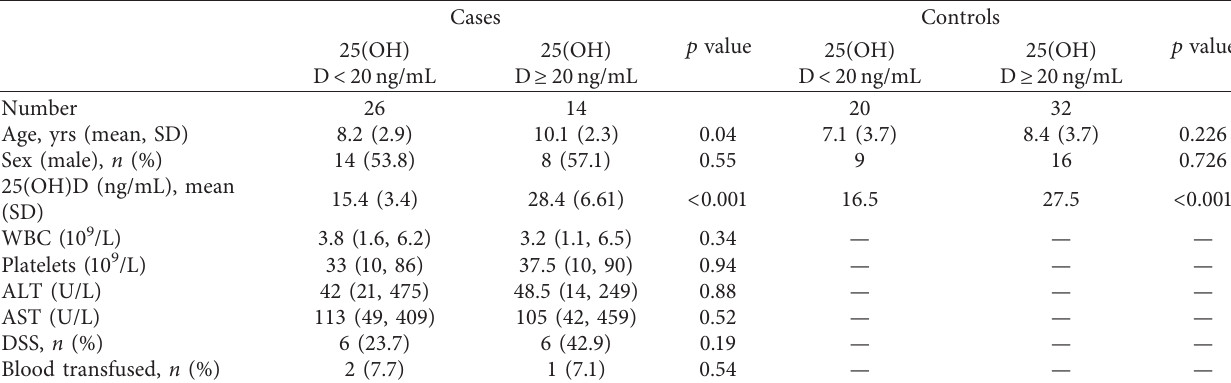
Table 2: Comparison of vitamin D-deficient ( < 20 ng/mL) and -nondeficient ( ≥ 20 ng/mL) groups among cases and controls.